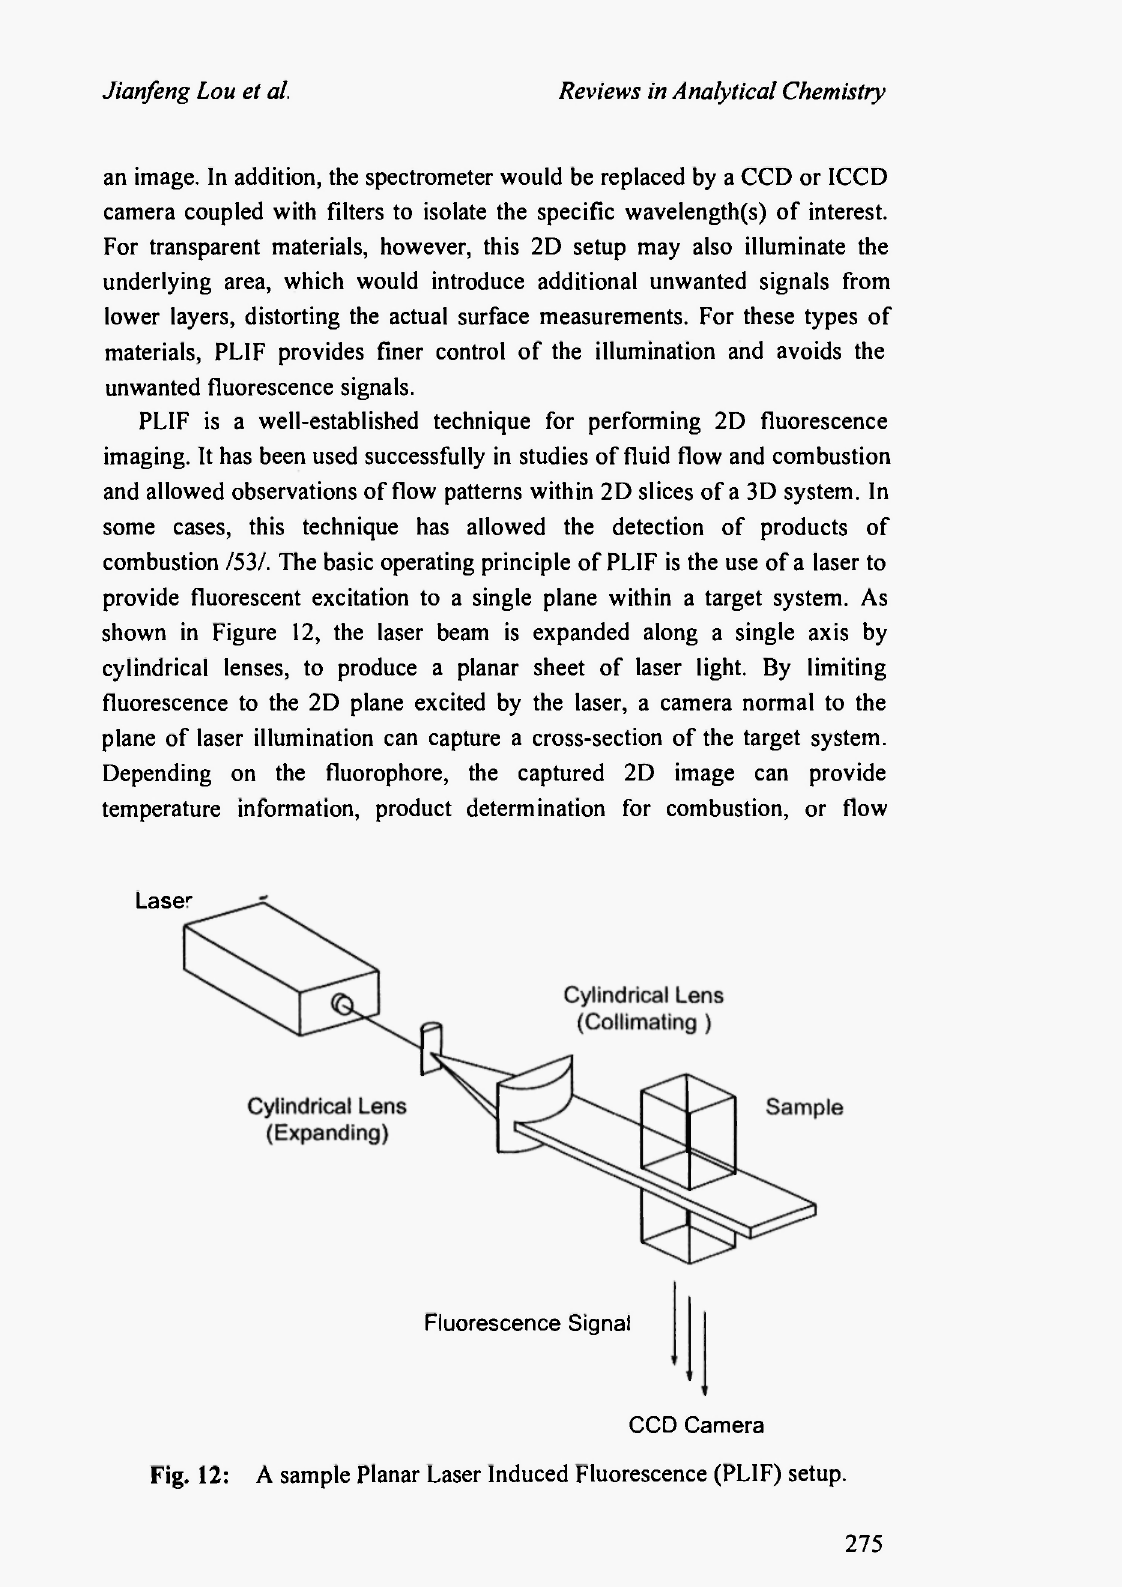
Fig. 12: A sample Planar Laser Induced Fluorescence (PLIF) setup.